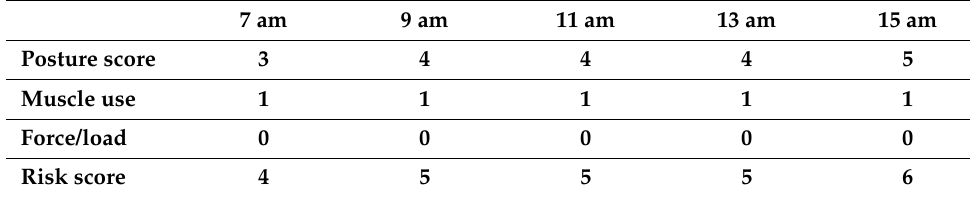
Table 3. Average score points assessed in different time intervals during the shift.